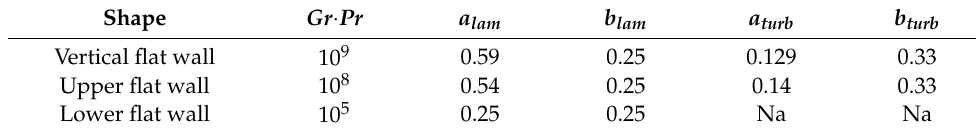
Table 1. The values of coefficients a and b from Equation (18). Shape Gr · Pr a lam b lam a turb b turb Vertical flat wall 10 9 Upper flat wall Lower flat